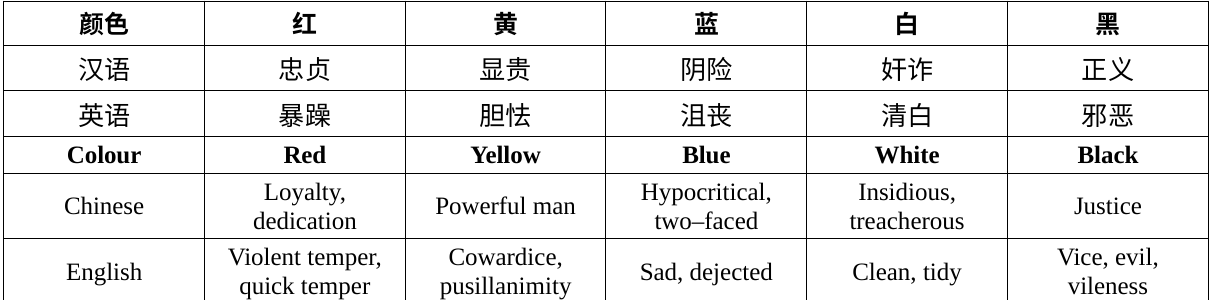
Table 1 - Differences in the interpretation of the colour pallette in Chinese and